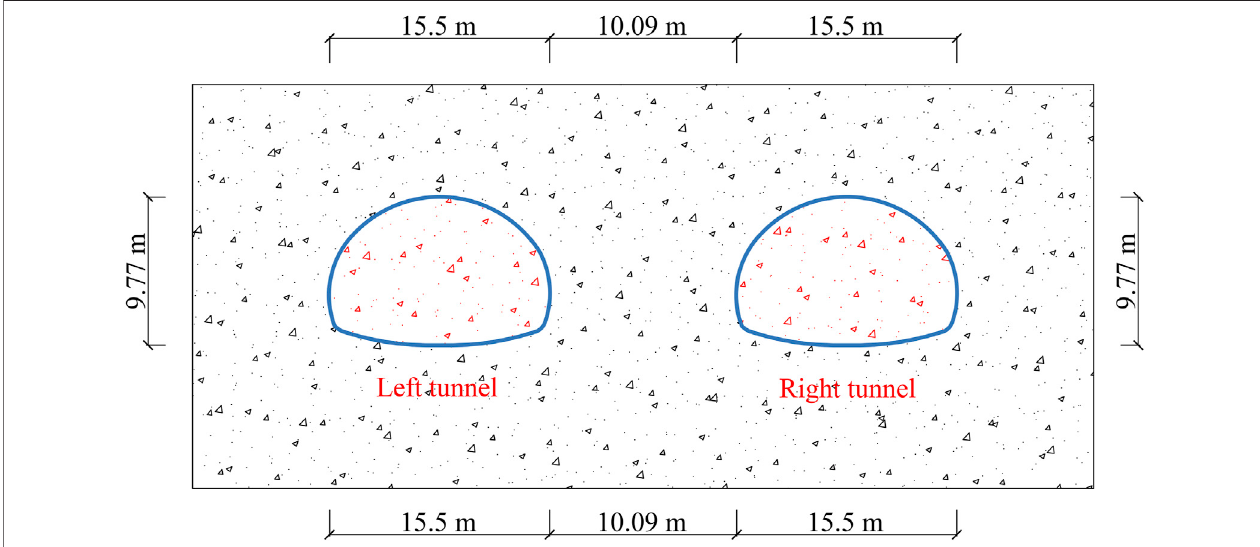
FIGURE 4 | Dimensions of Huangjiakuang tunnels and clear distance of the neighborhood tunnels.